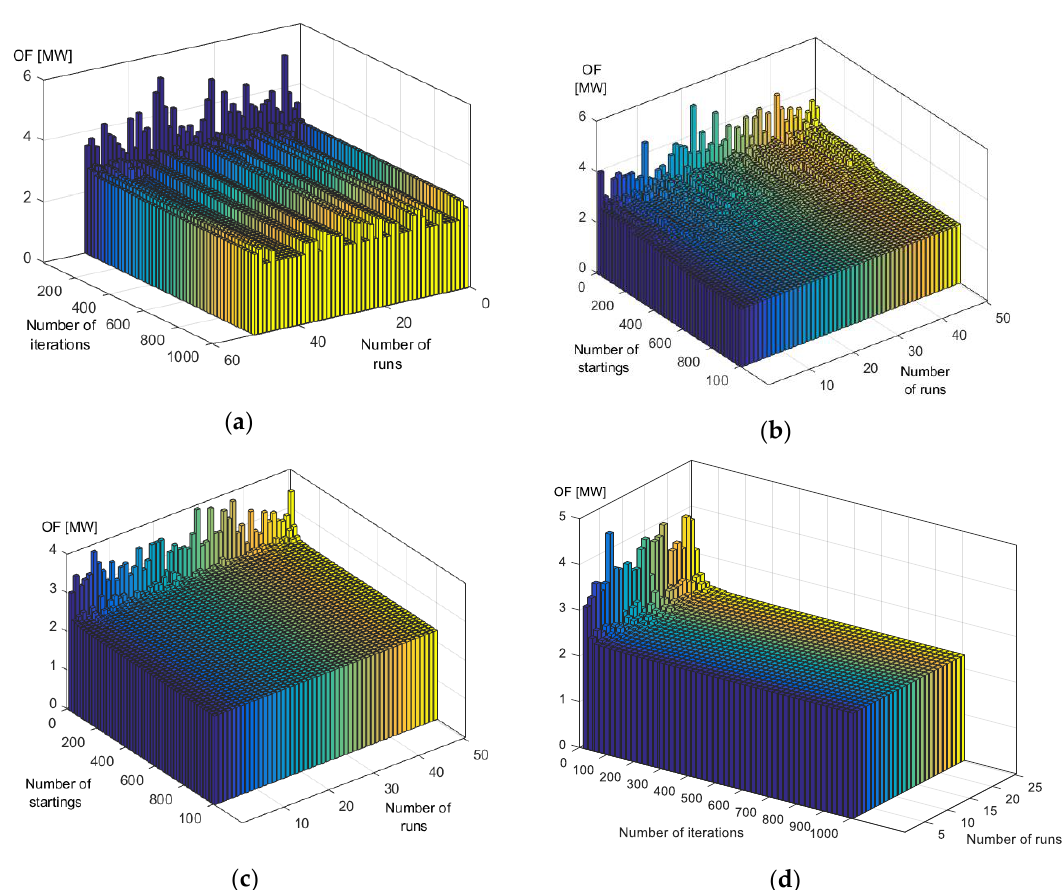
Figure 2. Change of optimal flow (OF) during the iterative procedure in multiple runs for the IEEE 9 test system ( a ) PSO, ( b ) GSA, ( c ) ABC, and ( d ) DE.